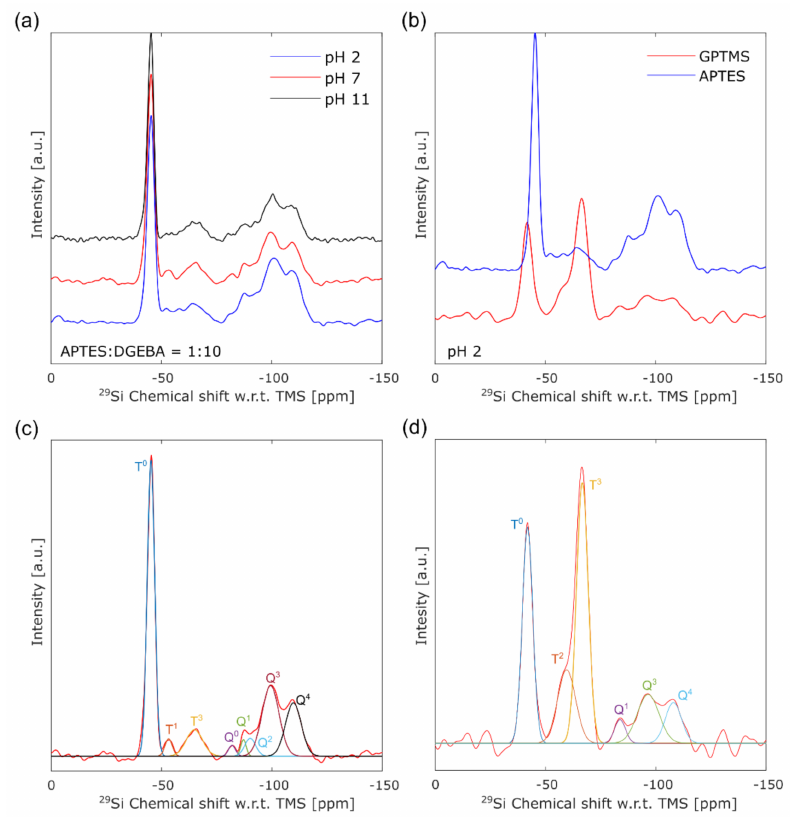
Figure 6. 29 Si NMR (CP-MAS) spectra of epoxy-SiO 2 nanocomposites. ( a ) Nanocomposites prepared with APTES (APTES:DGEBA = 1:10) at different pH. ( b ) Comparison of nanocomposites prepared with APTES and with GPTMS (both at pH 2). ( c ) Deconvolution of the peaks in the spectra for nanocomposites prepared with APTES. ( d ) Deconvolution of the peaks for nanocomposites prepared with GPTMS.